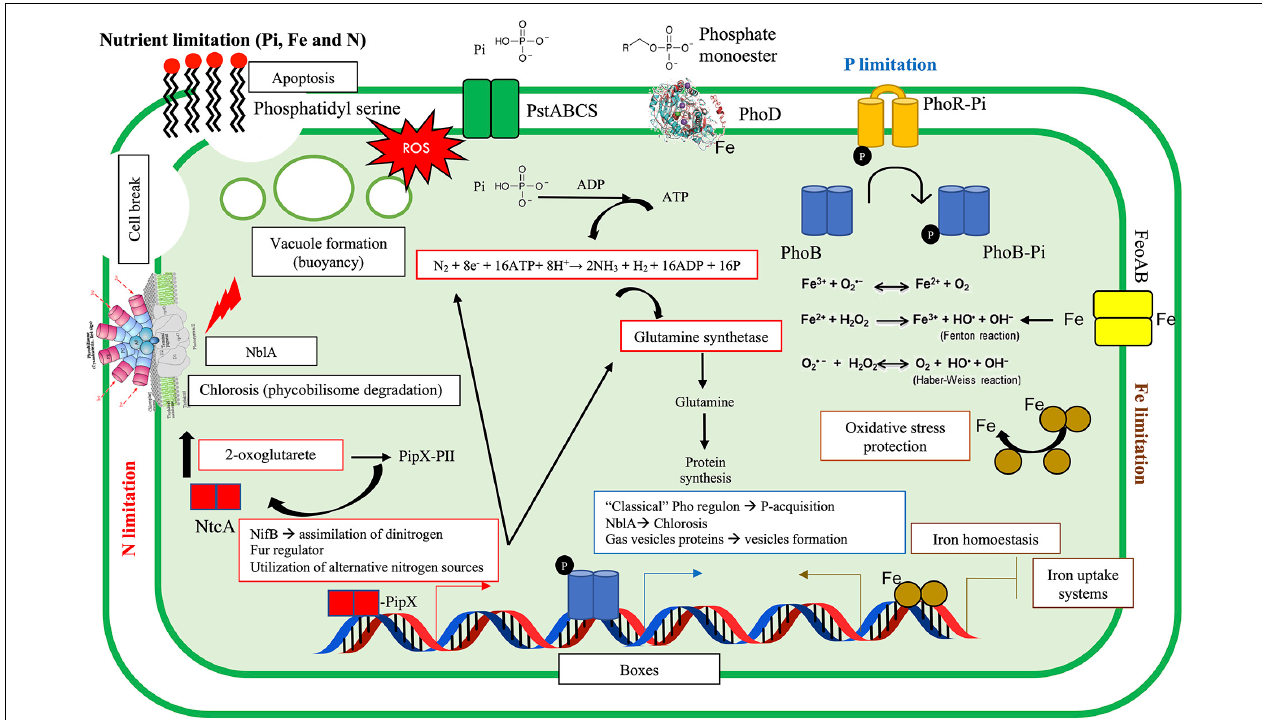
FIGURE 9 | Summary of PO 43 − , Fe, and NO 3 − interactions and the physiological and molecular responses of the cyanobacteria tested. Nutrient limitation can result in chlorosis, apoptosis, vacuole formation, reactive oxygen species (ROS) production, and growth inhibition. In such situations, cells may activate different molecular mechanisms. Under PO 43 − limitation (blue), the autophosphorylation of PhoR allows the phosphorylation of PhoB, regulating the P-response (i.e., expression of the “classical” Pho regulon, e.g., alkaline phosphatase, PhoD). Fur is a repressor (although it can play as activator) that responds to Fe limitation (brown) and inhibits/allows the transcription of the Fur regulon, through the association with divalent metal (i.e., Fe). Nitrogen limitation (red) triggers different responses through NtcA regulator. When N abundance is low, 2-oxoglutarate (2-OG) may increase, and this could bind to a complex called PII–PipX and breaks this association, allowing the disassociation of PipX, and the formation of PipX–NtcA. PipX is a coactivator of NtcA, and it is suggested that it can stabilize NtcA and would help to recruit RNA polymerase (Tiwari et al., 2015; Kaushik et al., 2016; Giner-Lamia et al., 2017). PO 43 − is represented as Pi.